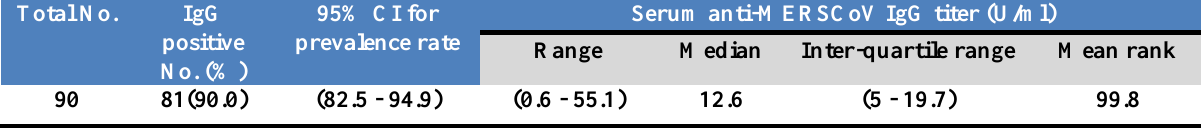
Table, 1: The positivity rate and titer of anti-MERS-CoV IgG among camels. Total